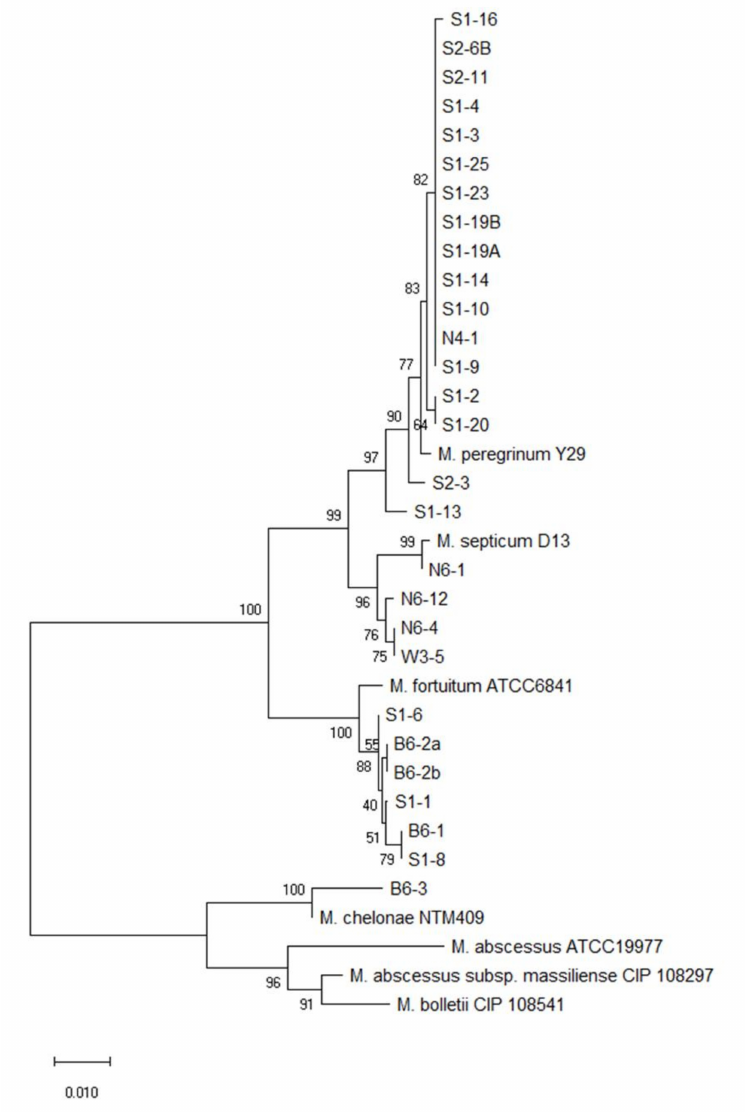
Figure 4. Phylogenetic analysis of RGM isolates in South Korean soils based on the rpoB gene sequences of the isolates and previously reported strains in NCBI GenBank. The tree was created using the neighbor-joining method, and bootstrap analysis was performed from 1000